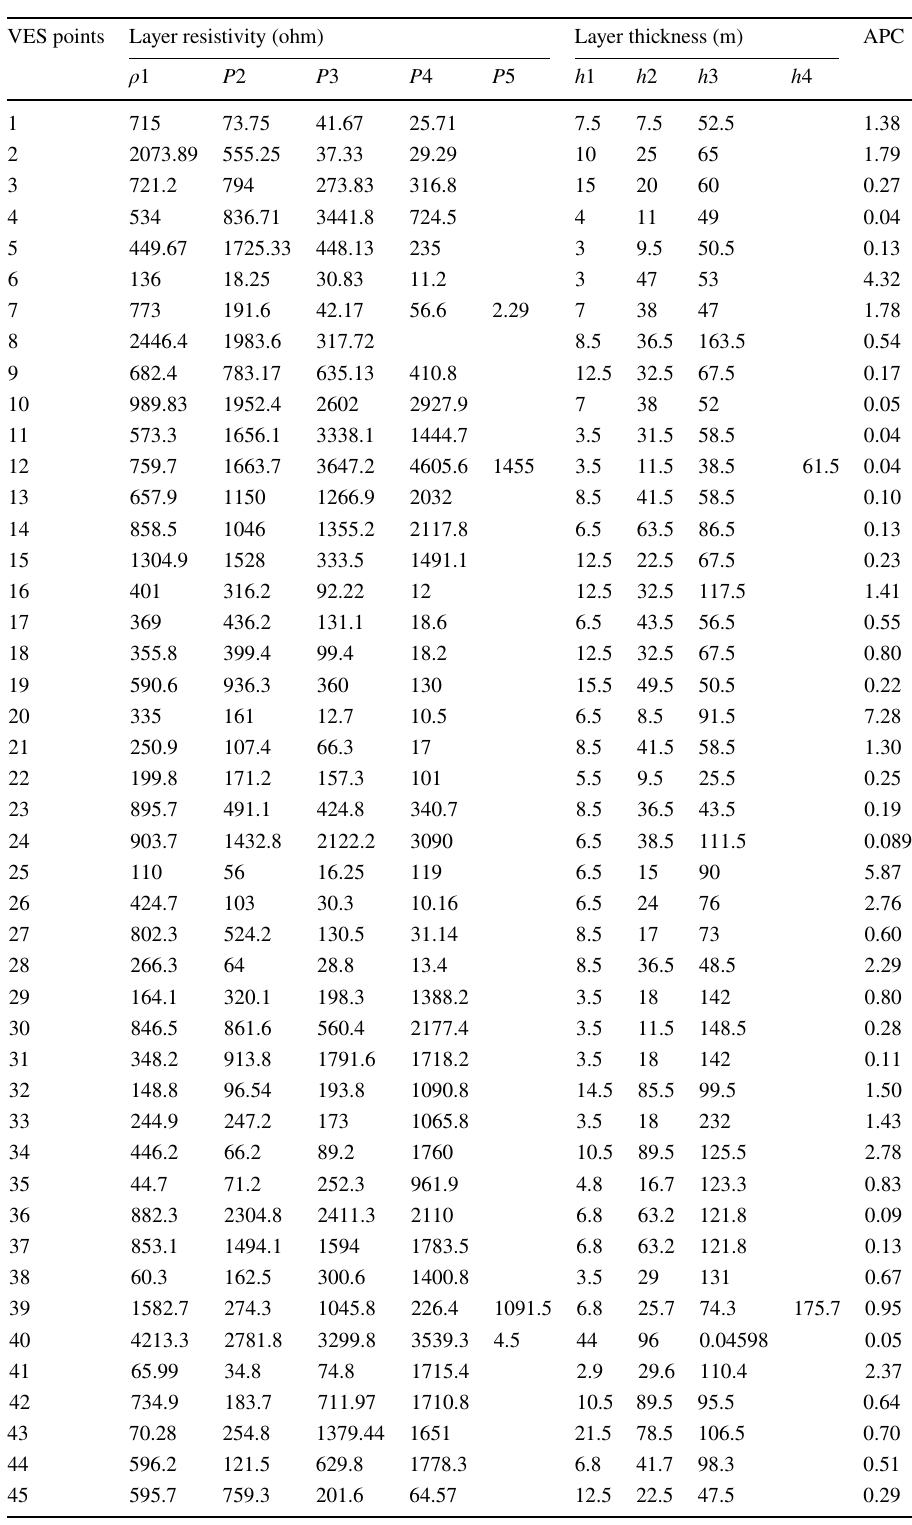
Table 1 Summary of layers resistivity, thickness and